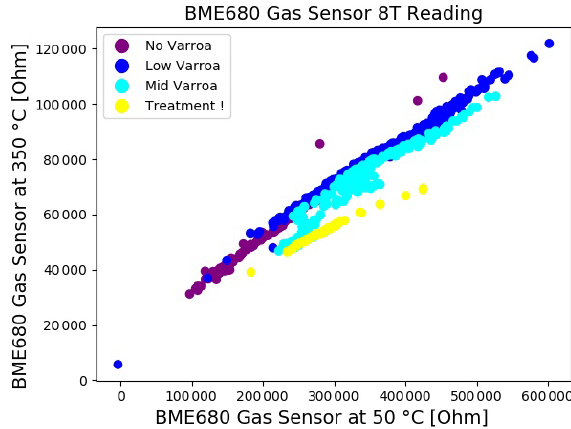
Figure 4. Campaign data for the period from 8 July to 11/19 September for the BME680 sensor at 50 and 350 ◦ C.